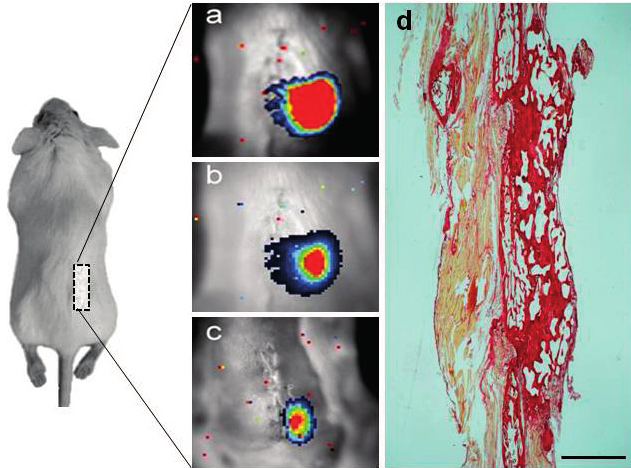
Figure 2. Noninvasive bioluminescence imaging (BLI) of sheep MSCs differentiation in subcutaneous implanted HA scaffolds, implanted in the back of severely immunodeficient mice and seeded with sheep MSCs previously transduced with the CMV:RLuc:mRFP reporter (a constitutively expressed reporter of cell number) and a cell differentiation reporter (OC:PLuc:eGFP), and imaged at ( a ) day 0; ( b ) 30 days; and ( c ) 60 days. The diagram illustrates the HA scaffold implantation sites (grey square) with seeded cells; ( d ) Production of new bone tissue by labeled sheep MSCs, having made possible the fusion of the two arthrodesed lumbar vertebrae (L4–L5). Picrosirius-red stain. Bar = 150